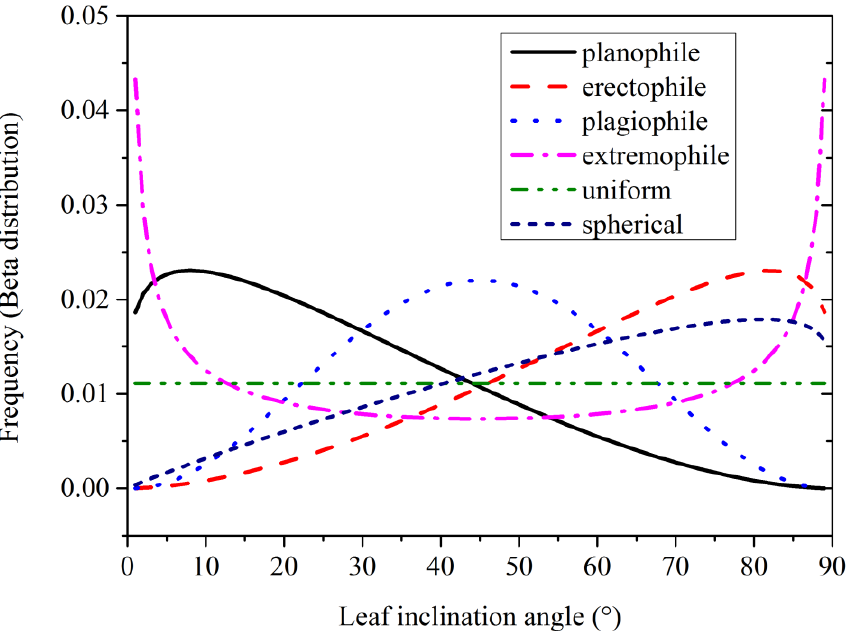
Figure 3. Beta distributions for the six theoretical leaf inclination angle distributions proposed by de Wit